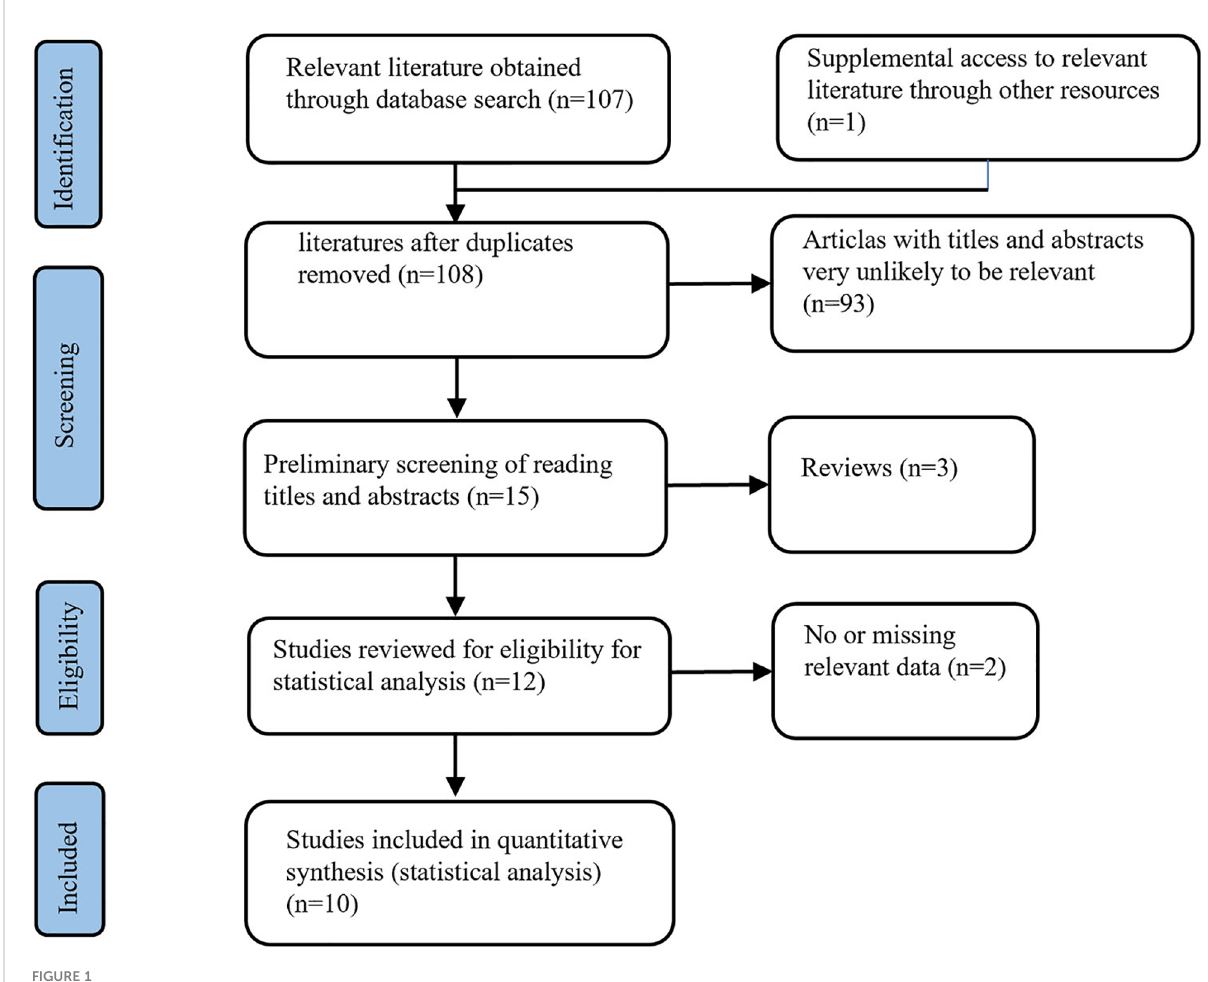
FIGURE 1 Flow chart for literature